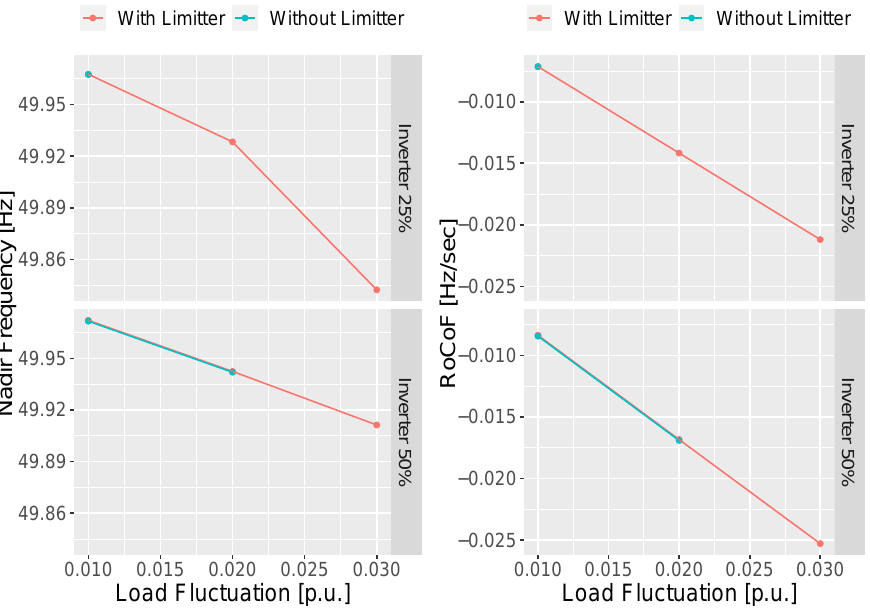
Figure 17. Nadir frequency and RoCoF of the load fluctuation with the limiter control